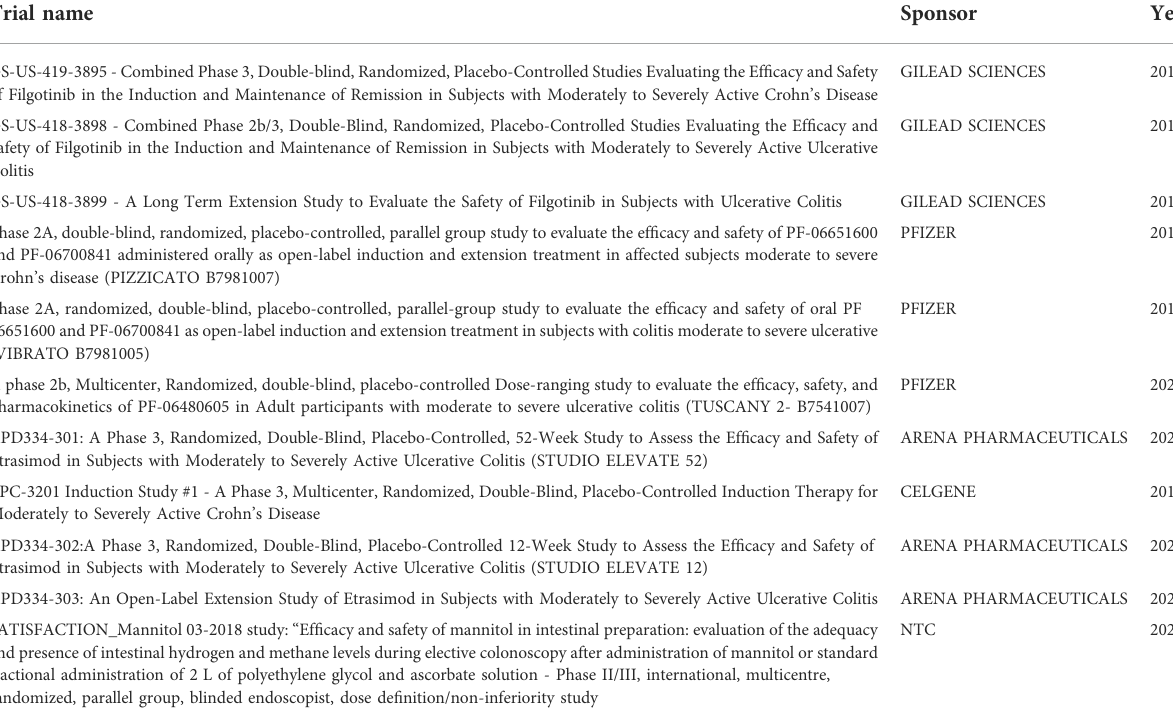
TABLE 1 List and description of pro fi t studies conducted (data